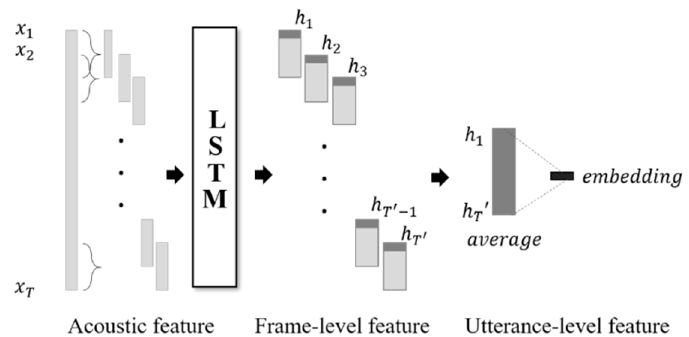
Figure 1. Extractor of LSTM-based speaker embedding framework.